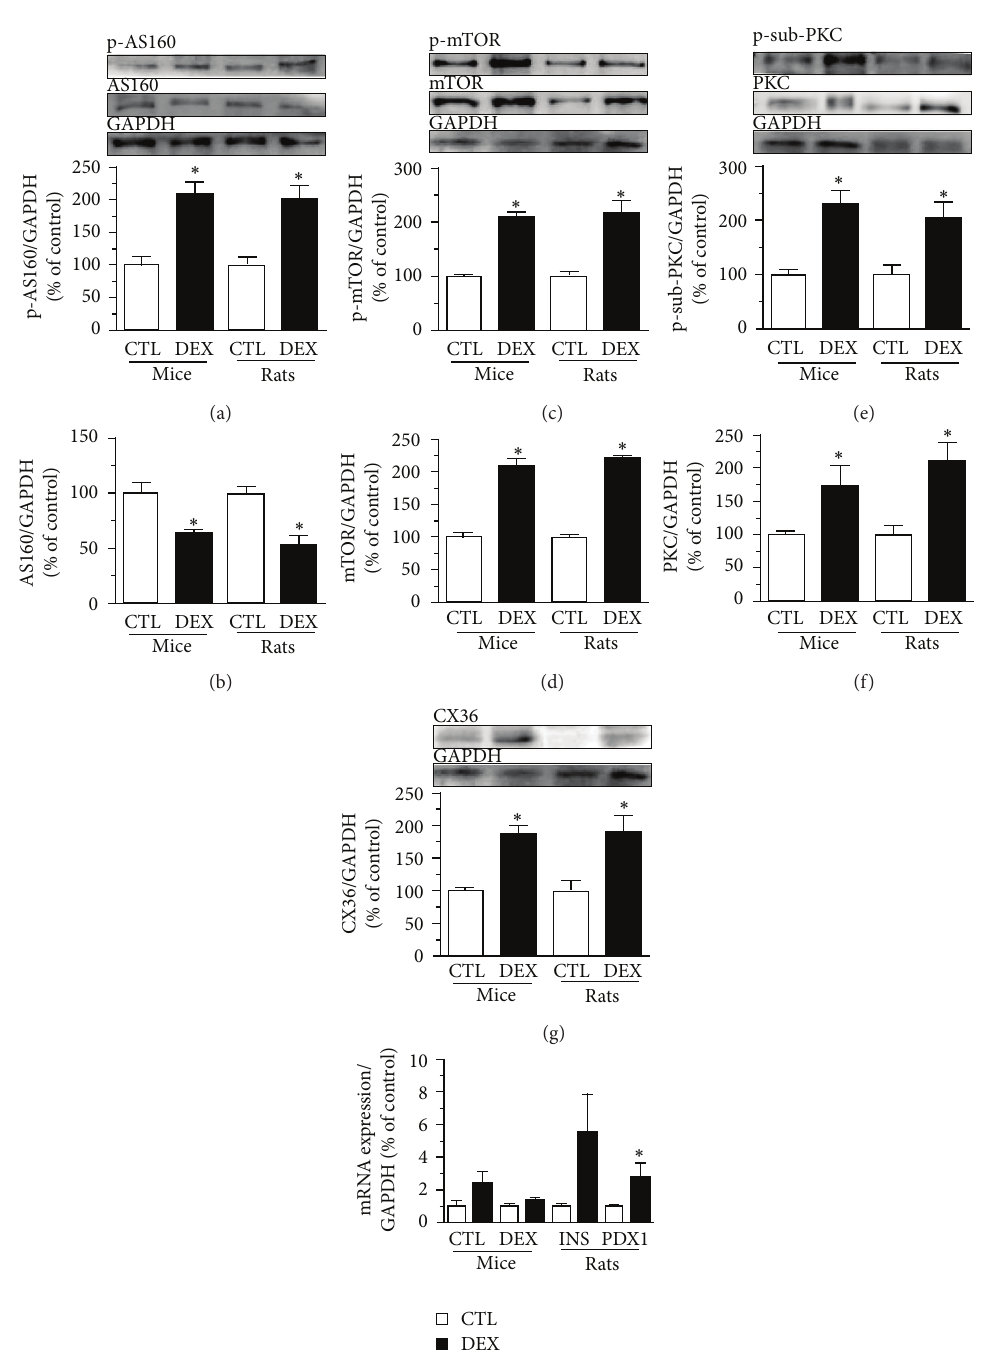
Figure 6: DEX treatment modulates proteins related to vesicle trafficking, protein synthesis, cell growth, and insulin secretion in pancreatic islets from both mice and rats. (a) Representative immunoblotting of phosphorylated and (b) total AS160 content. (c) Phosphorylated and (d) total mTOR content. (e) Phosphorylated substrates of PKC (range from 70 to 110kDa) and (f) total PKC content. (g) CX36 expression and (h) mRNA expression of INS gene and PDX1 in islets from DEX-mice and rats. Values are mean ± S.E.M.; 𝑛 = 4 rodents per group. ∗ Significantly different compared to CTL. Unpaired Student’s 𝑡 -test, 𝑃 ≤ 0.05